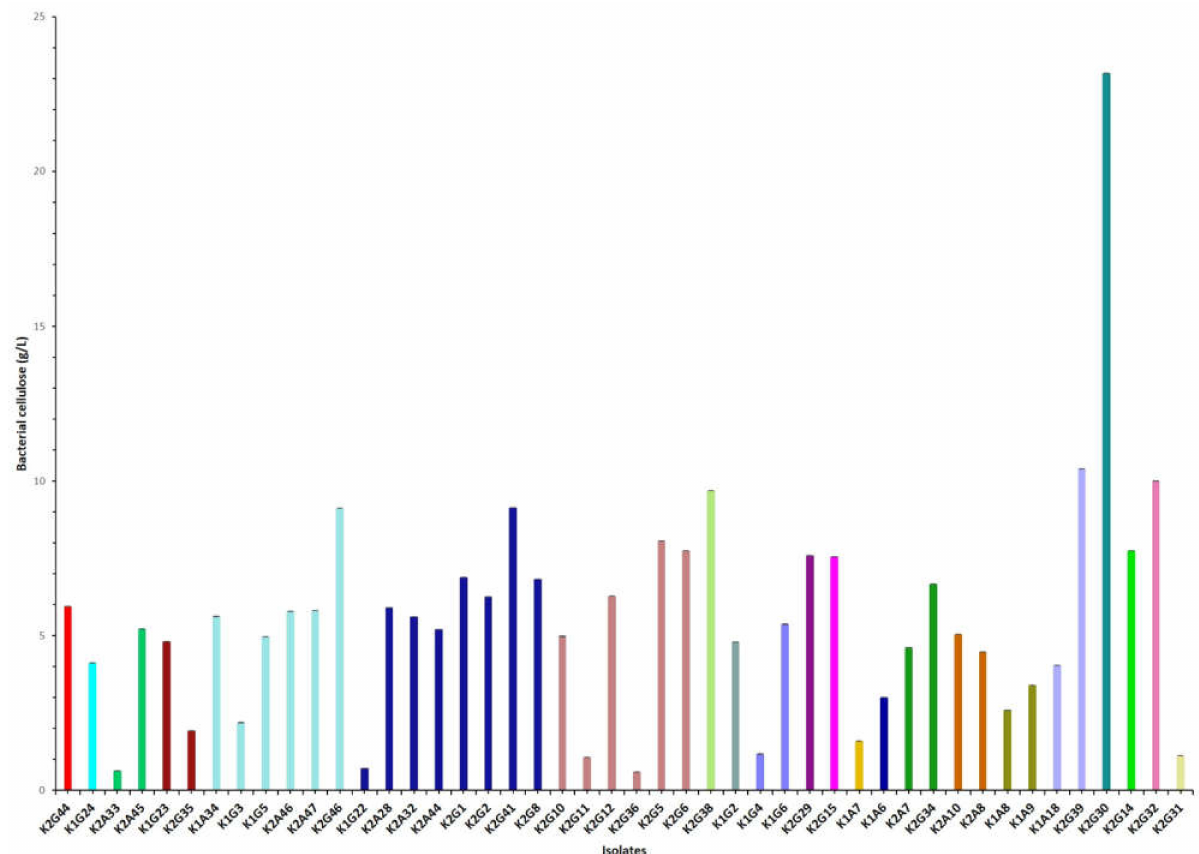
Figure 1. Bacterial cellulose yields of selected strains isolated from Kombucha tea. Each value is the mean of three parallel replicates ± standard